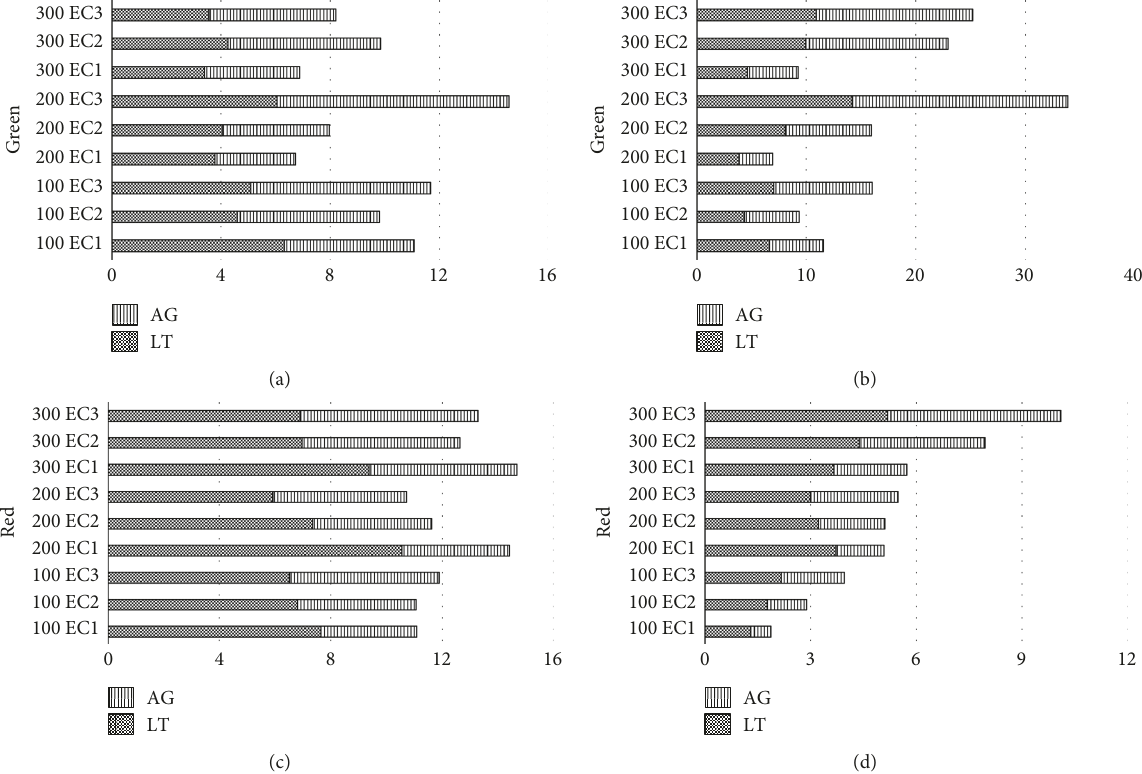
Figure 5: Total content of apigenin and luteolin (apigenin + luteolin) in perilla plants after 5 weeks of cultivation under different LI and EC treatments. (a) AG and LTcontent per leaf dry weight ( µ g · g − 1 ) in green; (b) AG and LTcontent per plant (mg · plant − 1 ) in green; (c) AG and LT content per leaf dry weight ( µ g · g − 1 ) in red; (d) AG and LT content per plant (mg · plant − 1 ) in